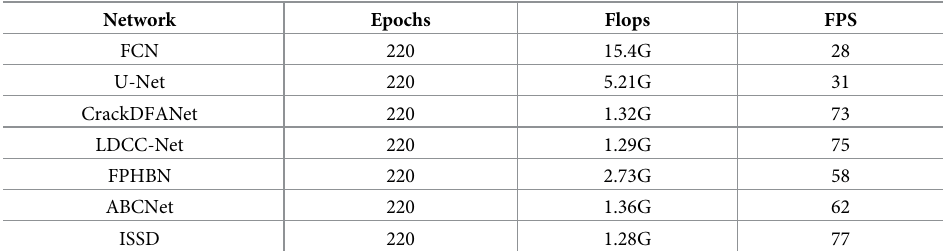
Table 6. The computational efficiency and computational complexity of different networks.